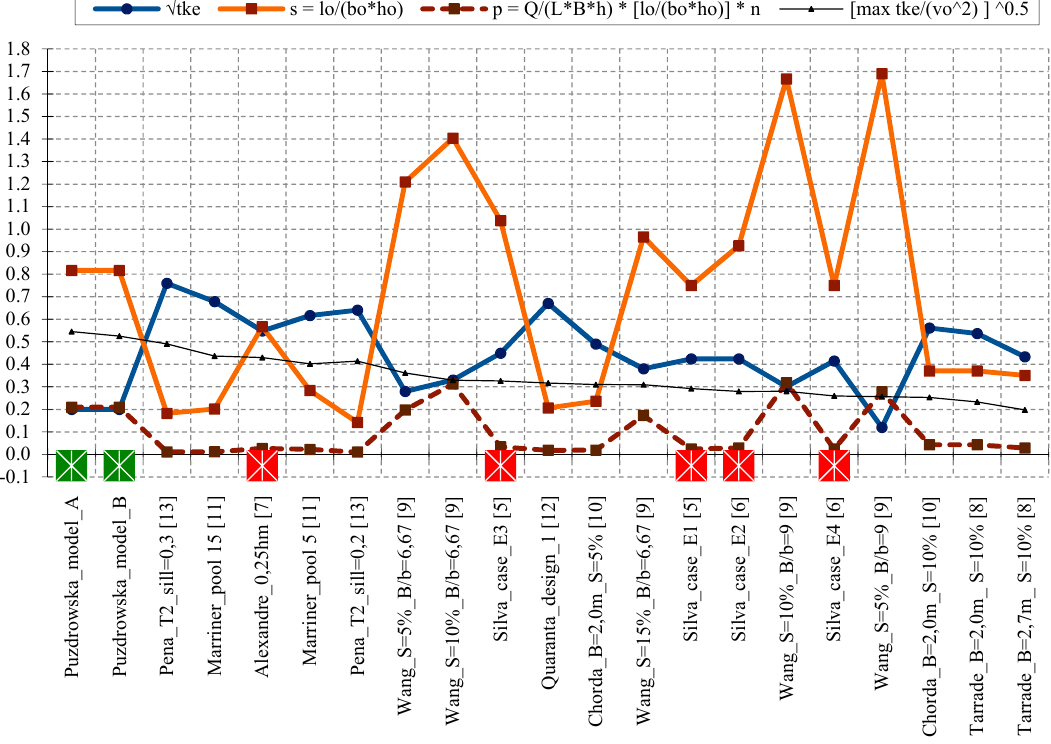
Figure 6. Diagram of relations between TKE and fishways’ geometry.